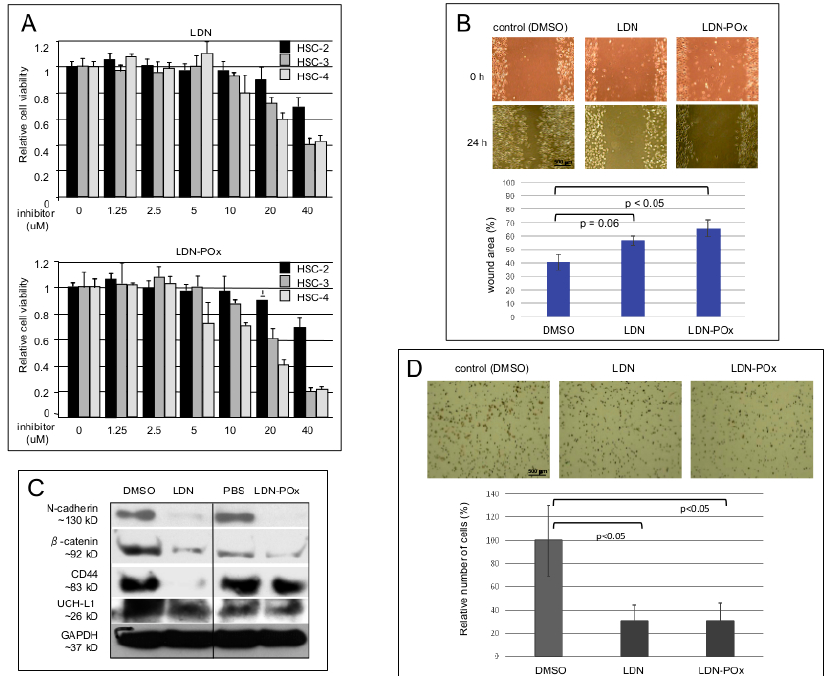
Figure 4. Both LDN and LDN-POx decrease expression of pro-metastatic factors as well as motility of oral squamous carcinoma (OSC) cells. ( A ) Determination of non-toxic concentrations of LDN and LDN-POx forms of the UCH-L1 inhibitor in metastatic human squamous carcinoma cells (HSC). HSC-2, -3 and -4 cells were treated with LDN or micellated LDN-POx forms of the UCH-L1 inhibitor and MTS assays were performed as described in Figure 3B. The results demonstrate that concentrations of the inhibitor less than 5 μ M did not affect the viability of all three cell lines. ( B ) Inhibition of UCH-L1 DUB activity reduces motility of highly metastatic HSC-3 cells. The cells were treated with either LDN or LDN-POx (3 μ M each) (DMSO as control). After 48 h incubation a scratch assay was performed as described in Figure 3C. The results of statistical analysis on the bottom indicate that both LDN and LDN-POx had inhibitory effect on HSC-3 cells motility. ( C ) Inhibition of UCH-L1 DUB activity reduces the expression of pro-metastatic factors in HSC-3 cells. Total lysates from HSC-3 cells treated for 72 h with both, free and micellated forms of UCH-L1 inhibitor (DMSO and PBS served as control respectively) were separated in 4–20 gradient PAGE, and Western blots with indicated antibodies (N-cadherin, β -catenin and CD44) were performed. Protein levels were normalized on GAPDH and UCH-L1. ( D ) Inhibition of UCH-L1 DUB activity reduces invasive capacity of HSC-3 cells. The cells treated with 3 μ M of LDN and LDN-POx (DMSO-treated cells are shown as control) were added to the insert of a transwell cell-culture chamber containing Matrigel and incubated for 24 h. Medium containing 10% fetal bovine serum was added to the bottom of the chamber. Cells that attached to the underside of the membrane were fixed, stained with hematoxylin and counted, and the average number of cells per field of view was determined (mean ± s.d.; n = 3). Scale bar ( B and D ): 500 μ m.